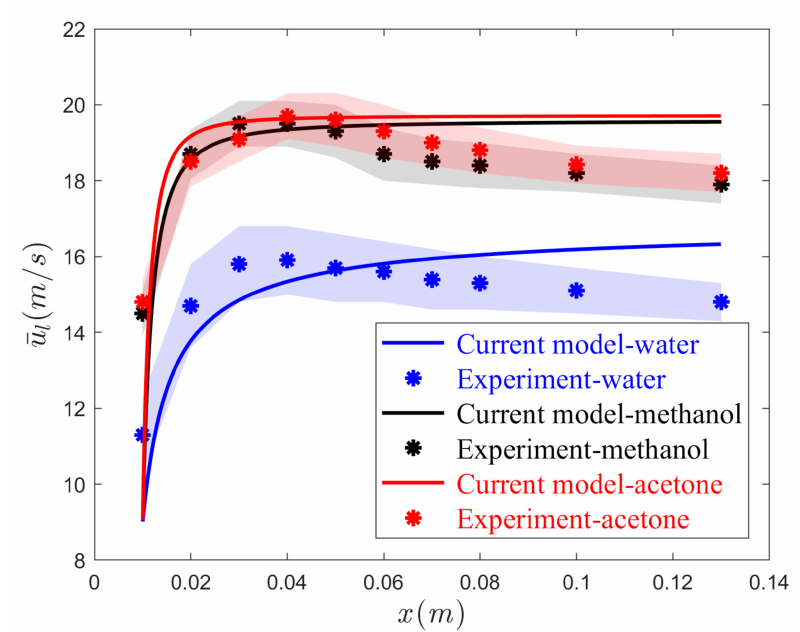
Figure 5. Experimental data (via high-speed flow visualizations) and current model results on ¯u l along the atomization axis for the three liquid feeds of water, methanol and acetone at u g = 125 m / s and u l = 2.5 m /